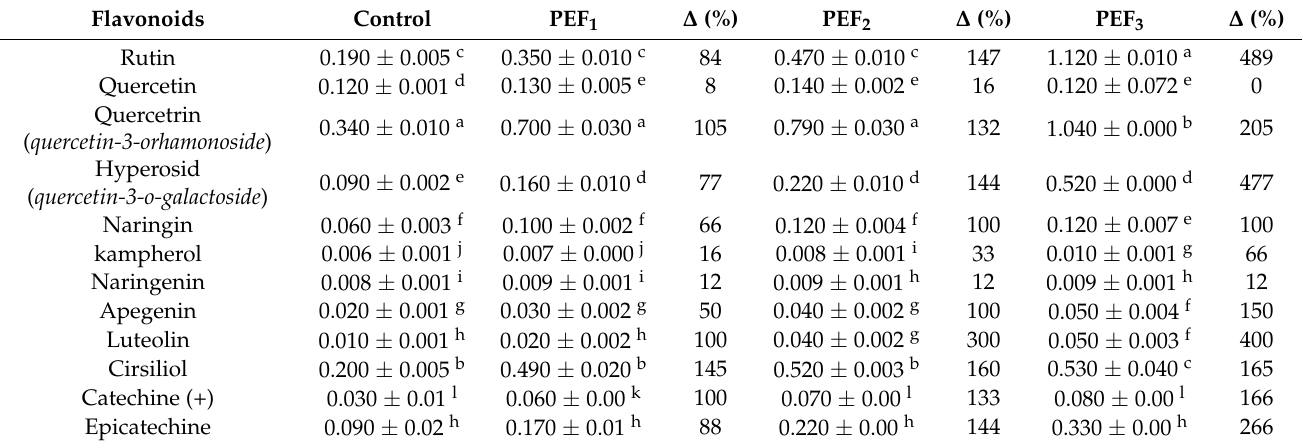
Table 2. Concentrations of flavonoid compounds (mg GAE.100 g − 1 FW) in date